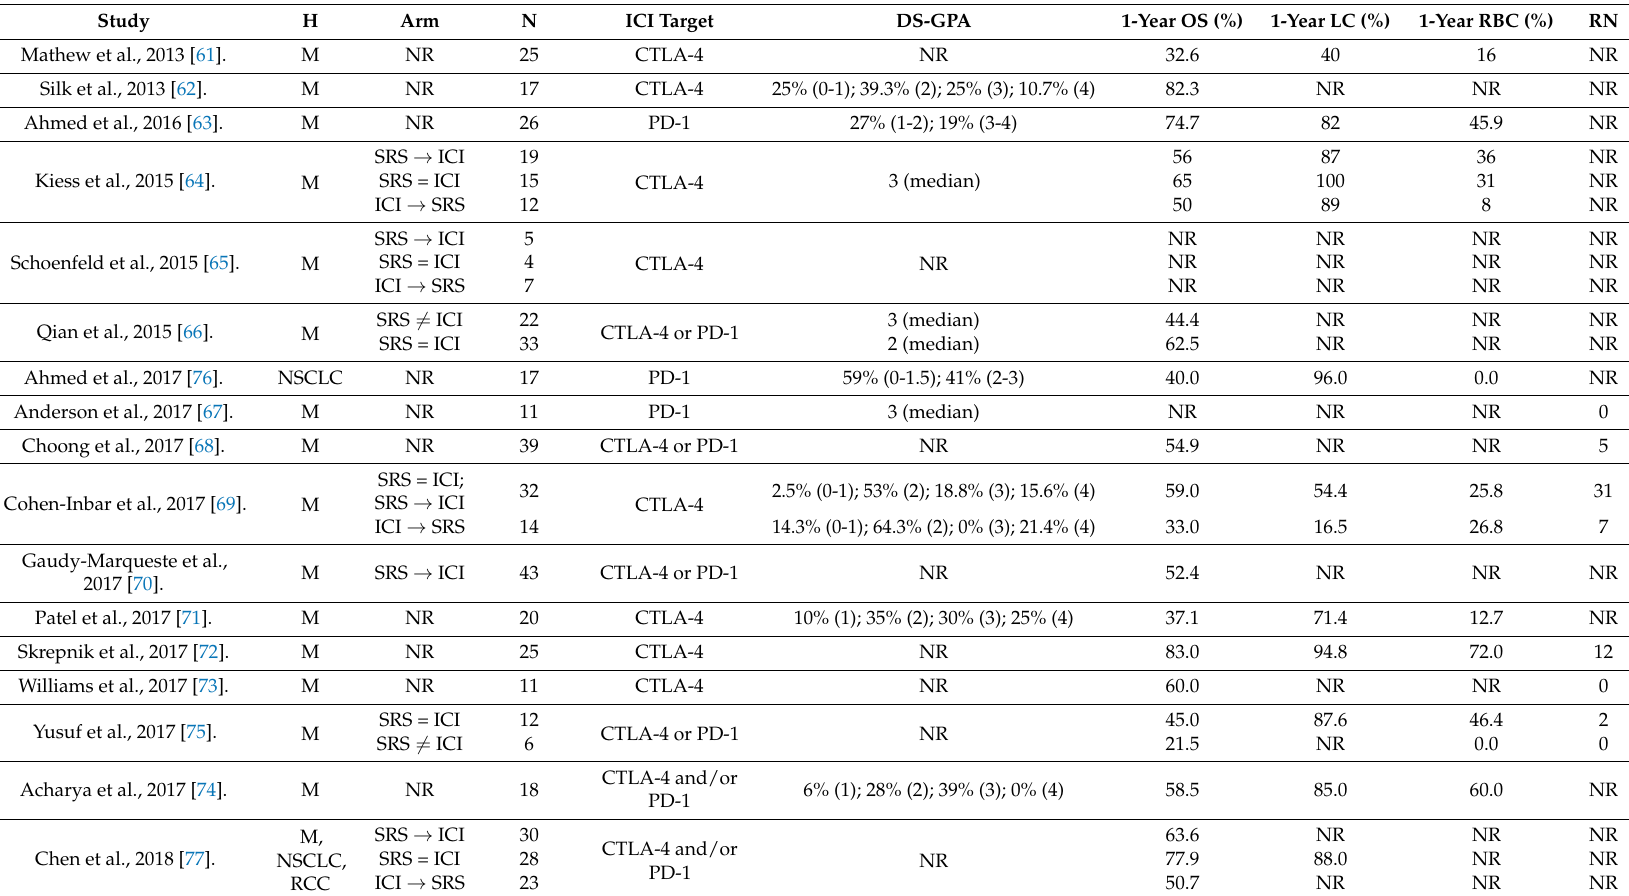
Table 2. Selected studies combining SRS with immune checkpoint inhibitors in brain